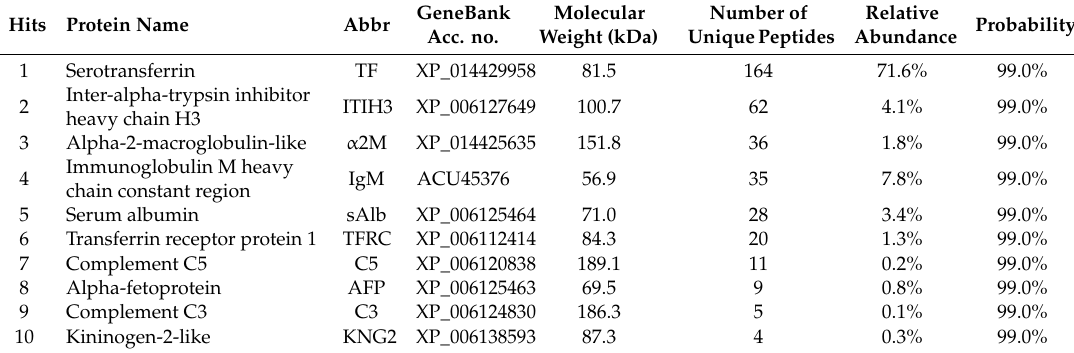
Table 1. Mass spectrometry results of protein bands ≥ 70 kDa excised from the gel electrophoresis.